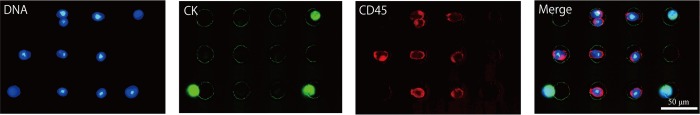
Cancer cell identification by immunostaining.Trapped DU145 cells and U937 cells stained with Hoechst33342 (blue), Anti-cytokeratin antibody (green) and Anti-CD45 antibody (red). Merged image identifies DU145 cells as a model of CTC (blue + green).